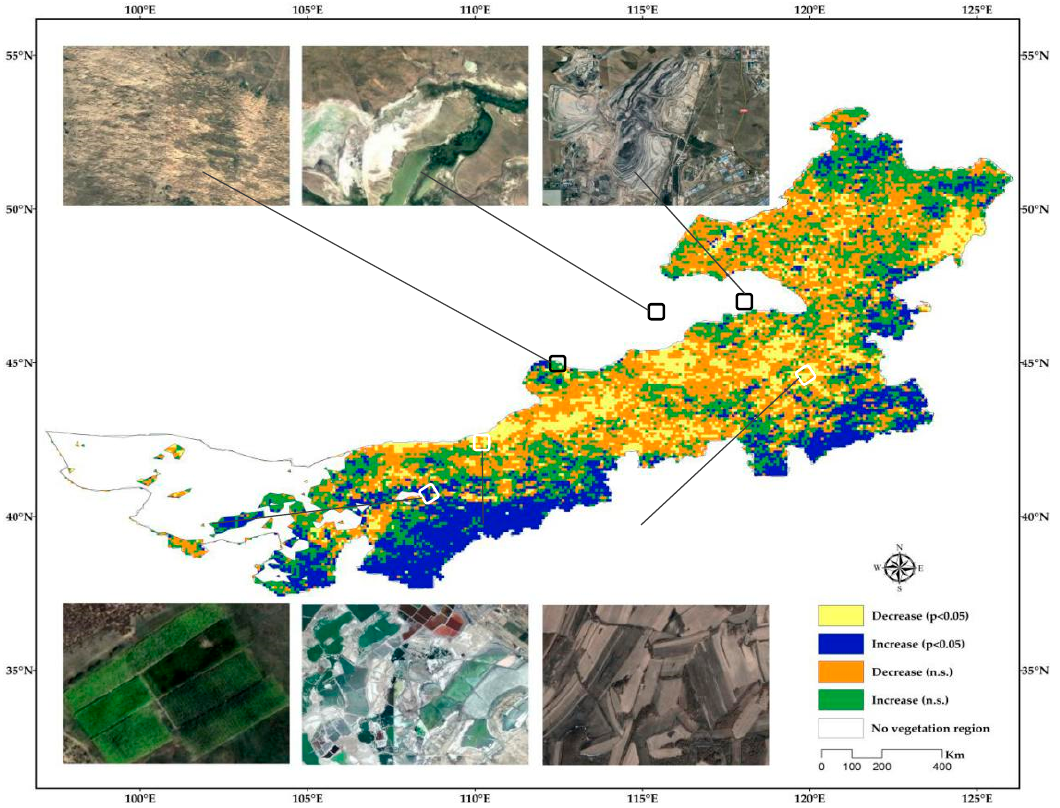
Figure 8. Residual trends of NDVI in Inner Mongolia during 1982–2015, and the location of the significant changes of NDVI residuals in Google map.